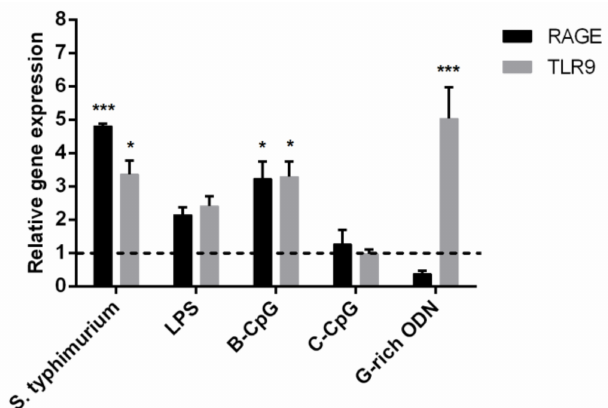
Figure 2. Relative transcription levels of genes encoding RAGE and TLR9 proteins in human neutrophils (2 × 10 6 /mL) after 1h incubation at 37 ◦ C with the addition of 0.5 × 10 8 S. typhimurium bacteria, 1 µ g/mL LPS or 1 µ M ODNs. Values measured by qRT-PCR are normalized to vehicle (HBSS/HEPES) control (dotted line). Data are means ± SEM from three independent experiments. * p < 0.05, *** p < 0.005, compared with the control. Two-way RM ANOVA followed by Dunnett’s multiple comparison test was used.